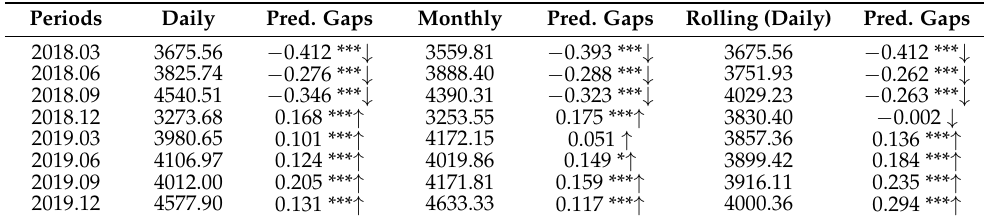
Table 7. Sensitivity results for daily, monthly, and rolling data.